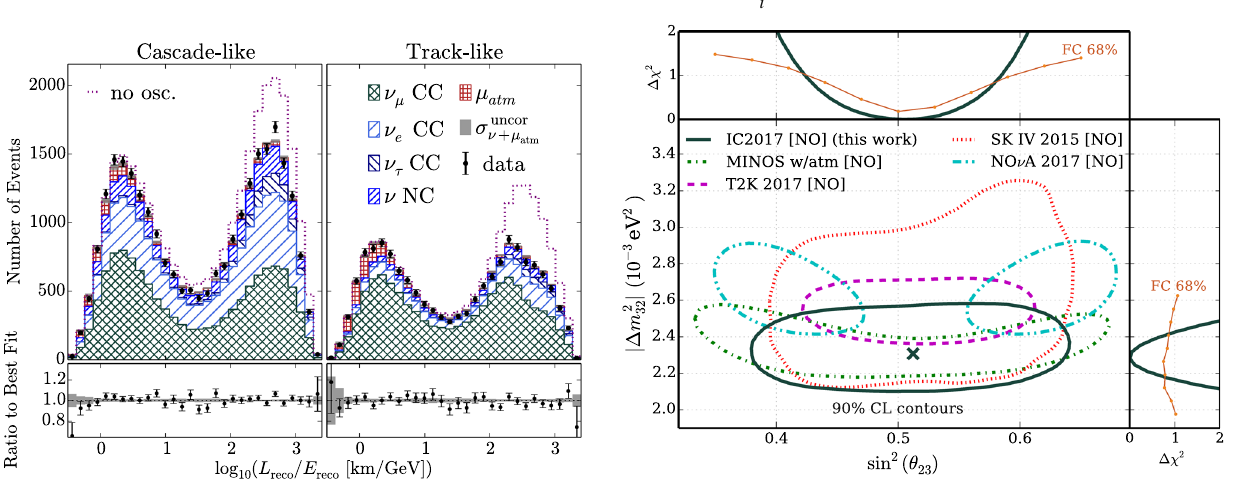
Fig. 7 Left panel: event count as a function of reconstructed L/E. The expectation with no–oscillations is shown by the dashed line, while the best fit to the data (dots) is shown as a the full line. The hatched histograms show the predicted counts given the best-fit values for each component. σ uncor ν + μ representstheuncertaintyduetofiniteMonteCarlo atm statistics and the data-driven atmospheric muon background estimate.